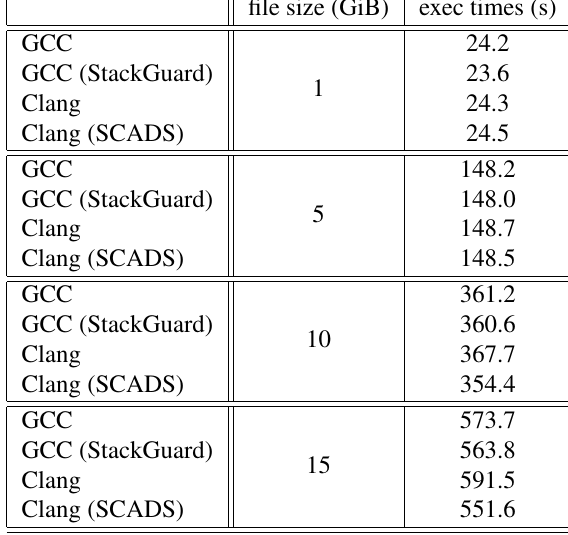
Table 4. The execution times of the run-length-encoding from listing 19 for different sizes of the input